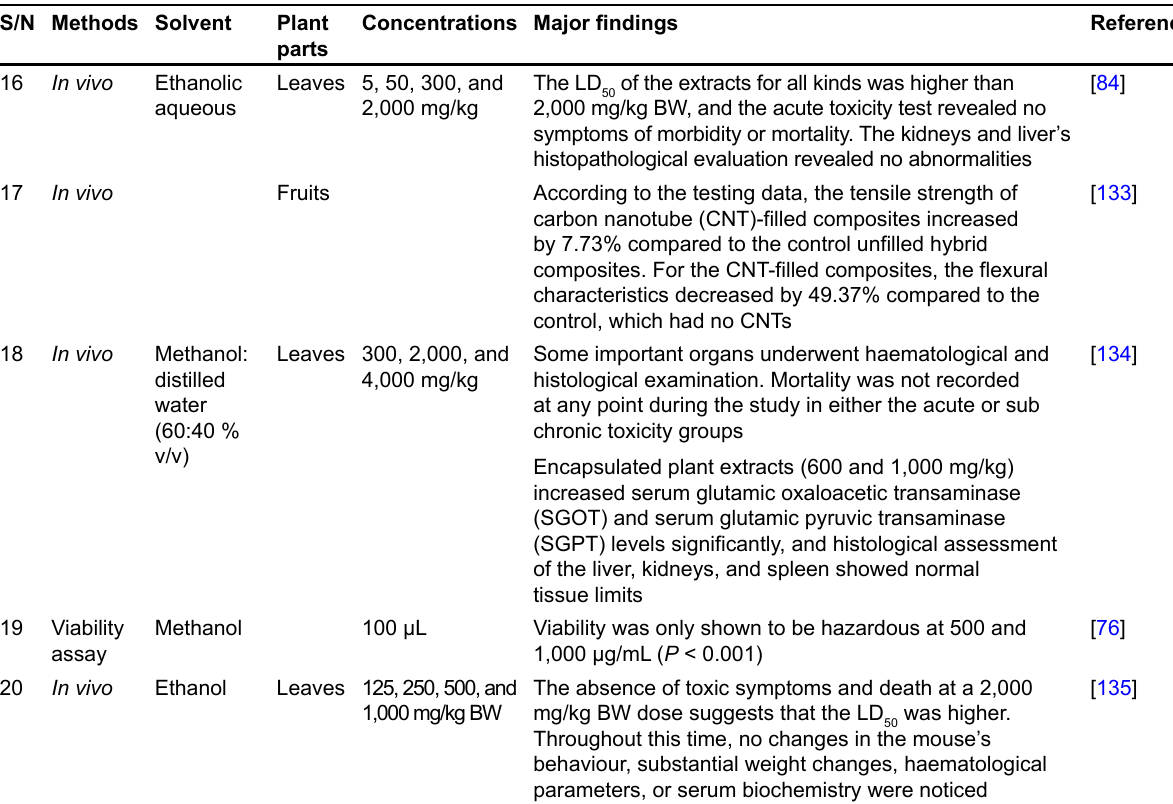
Table 9. Toxicity evaluation of FD ( continued